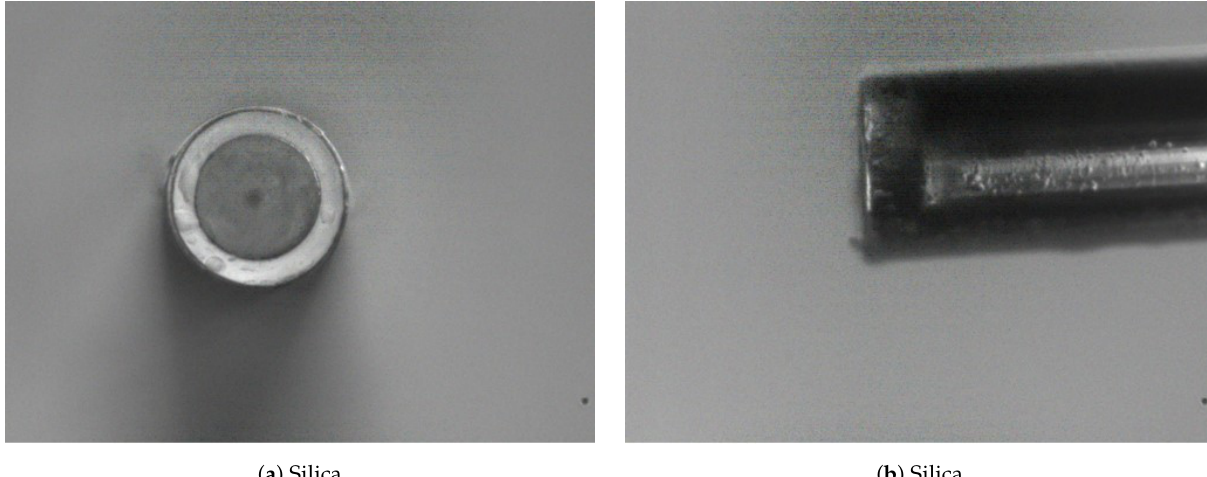
Figure 6. ( a ) Sensor blank extending approximately 30 mm from the fibre clamp, with 8 mm of exposed fibre. ( b ) Sensor immersion rig.